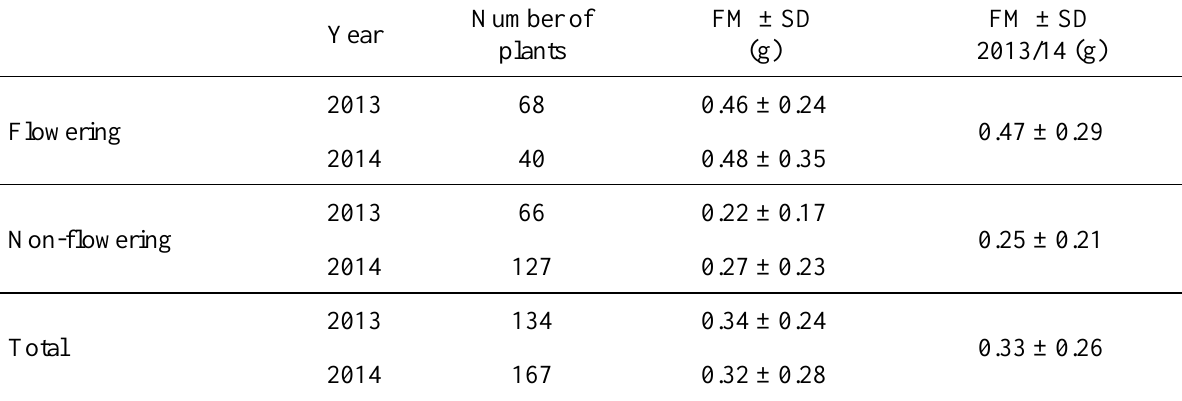
Table 2. Fresh mass (FM) of individual Drosera intermedia plants growing on the Sphagnum papillosum field. Flowering = plants with stalk(s); Non-flowering = plants without stalk(s); Total = flowering + non-flowering plants. Harvest dates: June–September 2013 and May–September 2014 ( n = 23; 2013: 2 plots × 4 months; 2014: 3 plots × 5 months). We registered no D. intermedia plants growing on Sphagnum palustre